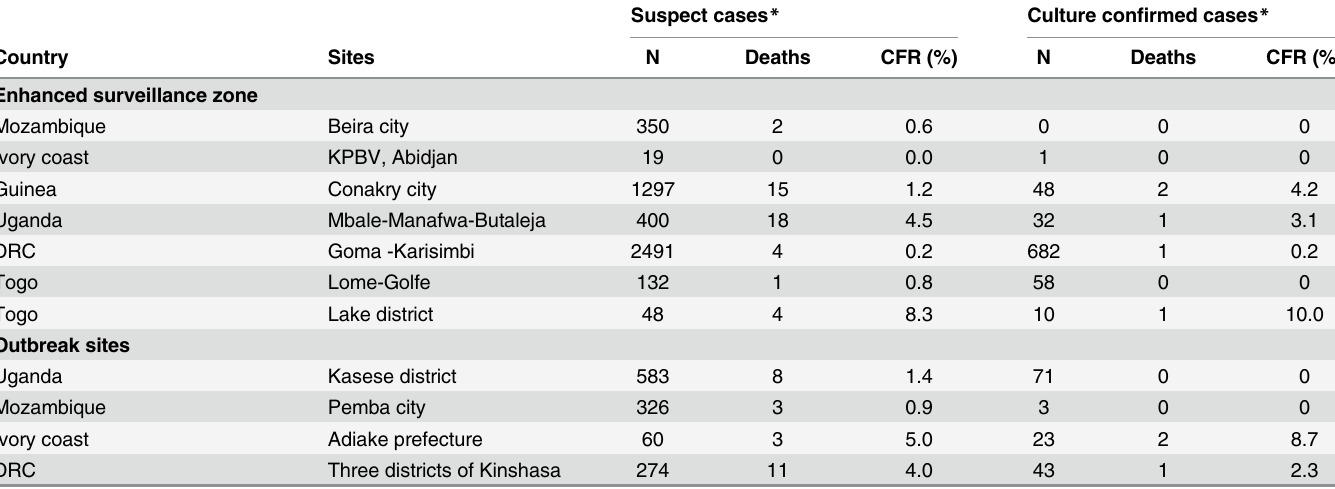
Table 6. Case fatality ratio (CFR) among suspected and culture confirmed cholera cases. N =